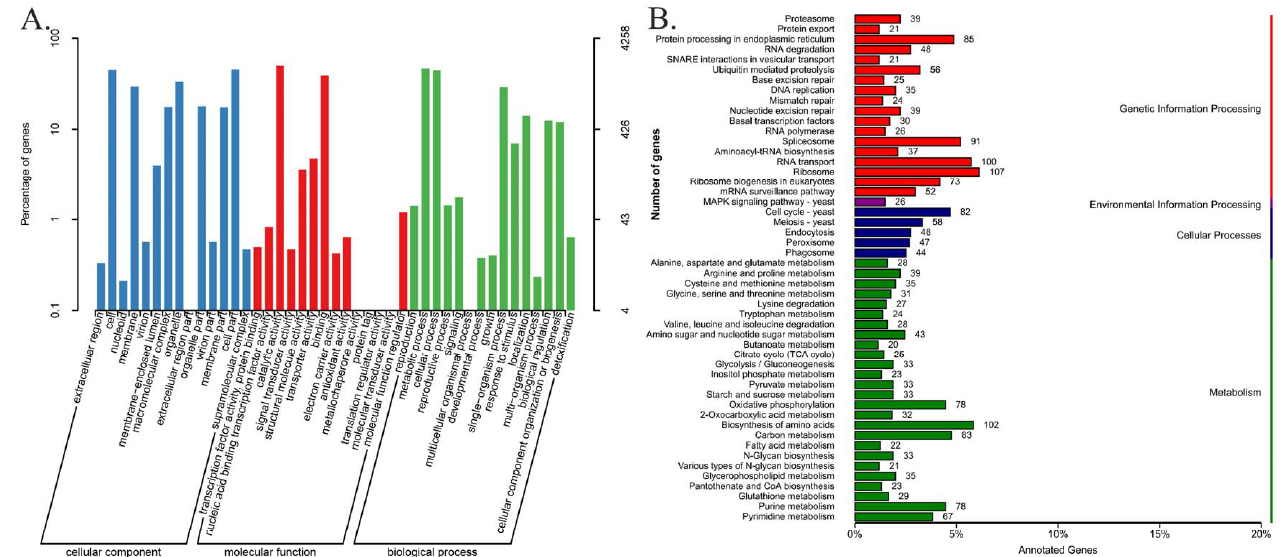
Figure 2. The mainly functional annotation of the G. purpuraceus genome. ( A ) Gene Ontology (GO) functional annotation; ( B ) Kyoto Encyclopedia of Genes and Genomes (KEGG) functional